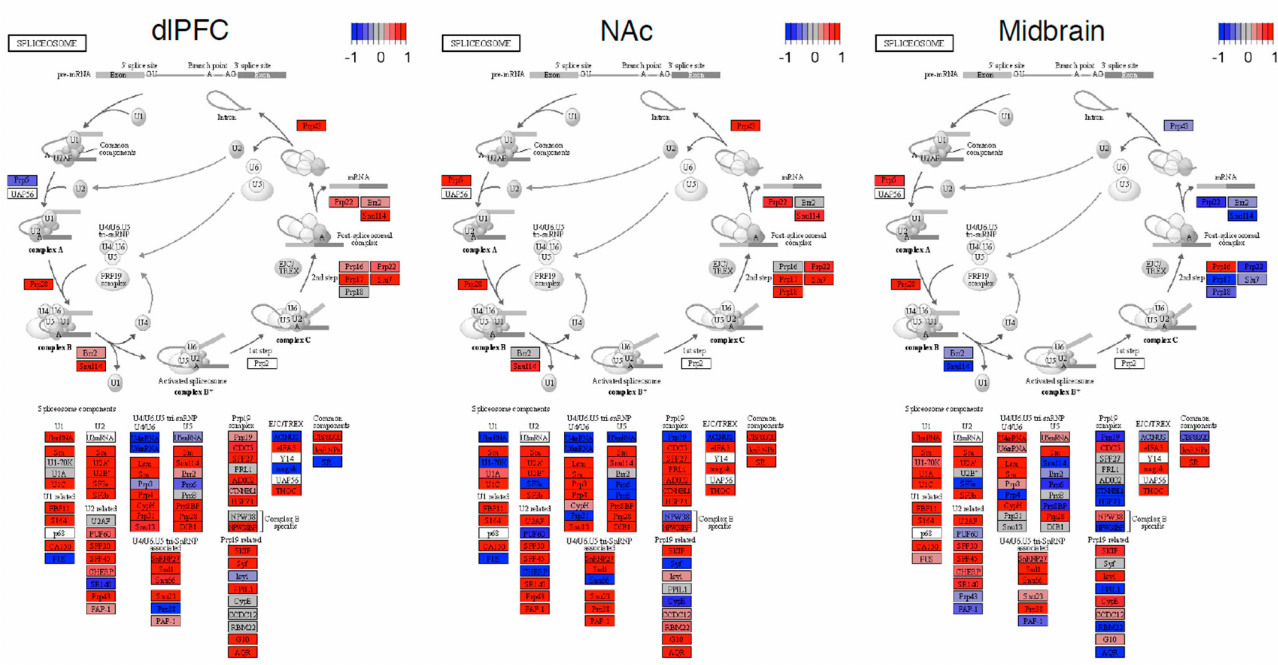
Figure 5. Spliceosome pathway in OUD neurocircuitry. KEGG pathview plots of the spliceosome pathway organized into specific components and stages of the spliceosome. Red denotes an increased expression and blue denotes a decreased expression for a gene in OUD. The − 1 to +1 scale for these plots uses a differential expression (Wald)